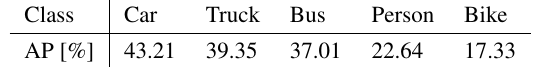
Table 1. Average Precision of the top 5 classes obtained by our trained CNN model. Following the Berkeley Driving Dataset challenge, an AP 75 is used which correpsonds to a threshold of